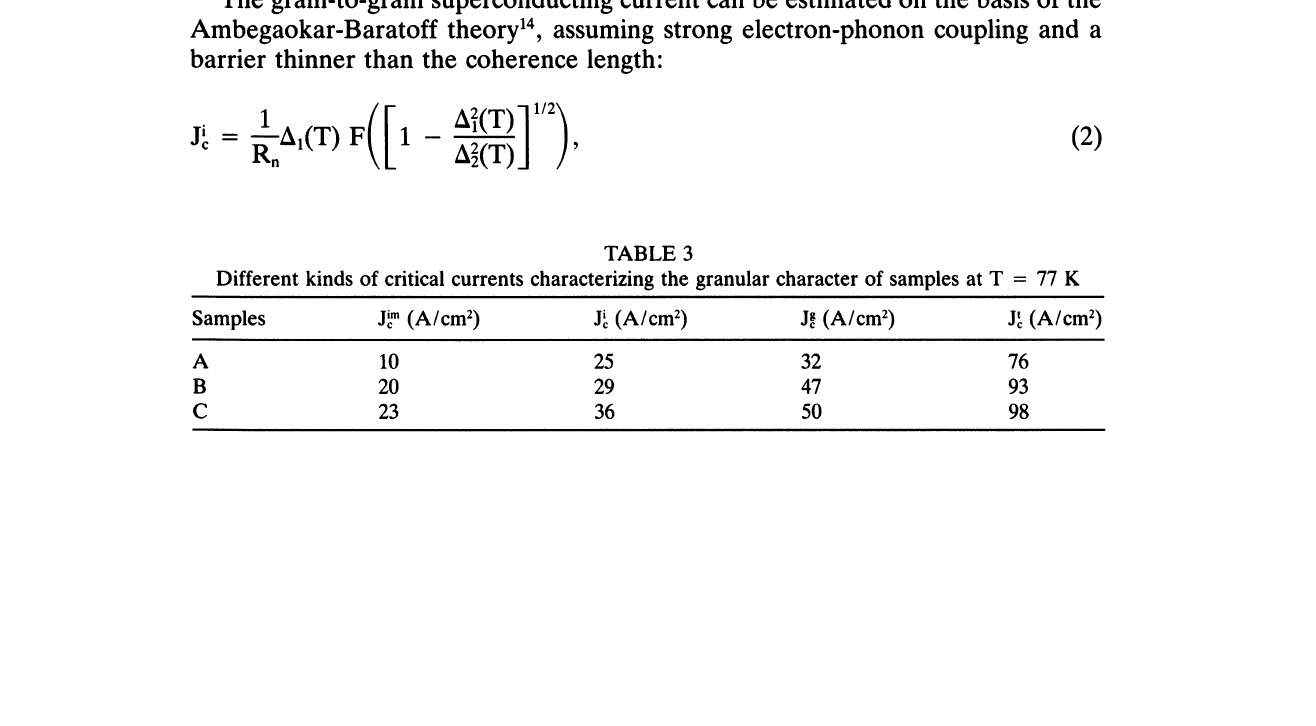
Different kinds of critical currents characterizing the granular character of samples at T 77 K Samples jim (A/cm 2) ji (A/cm 2) j (A/cm 2)